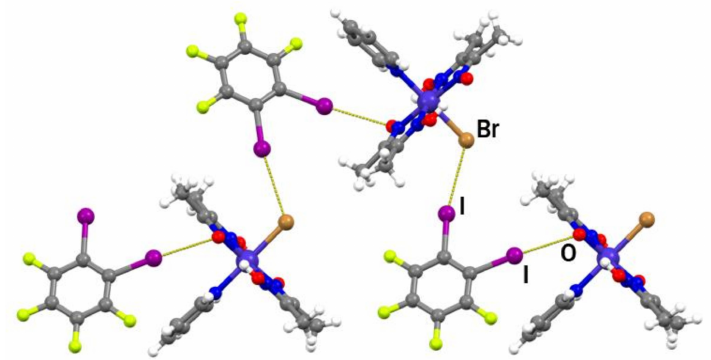
Figure 3. Halogen-bonded chain in the crystal structure of ( I )( 12tfib ).